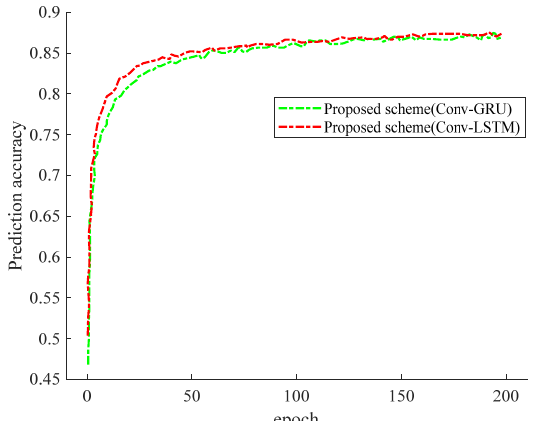
Figure 13. Comparison of prediction accuracies of Conv-GRU and Conv-LSTM prediction schemes.